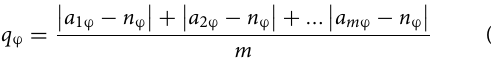
FIGURE6 Per capita consumption expenditure vs. total consumption